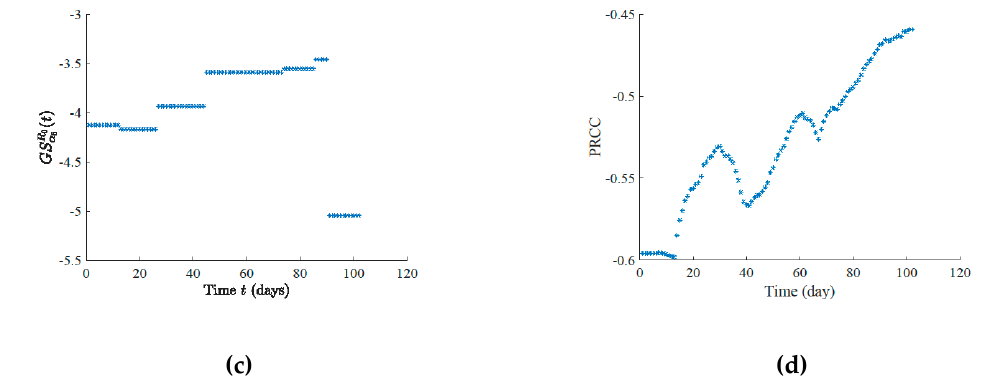
Figure 4. The effect of the rate of isolation on the outbreak. An exponential-like decline in the size of the epidemic if the rate of isolation of suspected cases is within a range of 50% around the estimated value of 0.94 for (a) patients and (b) both types of HCWs. Local (c) and global (d) sensitivity of the values of R 0 over time to the rate of isolation ( α 6 ). In (d) partial rank correlation coefficient (PRCC) of the rate of isolation and R 0 over time shows a negative significant correlation ( p -value = 0). That association weakened over time but stayed significant.